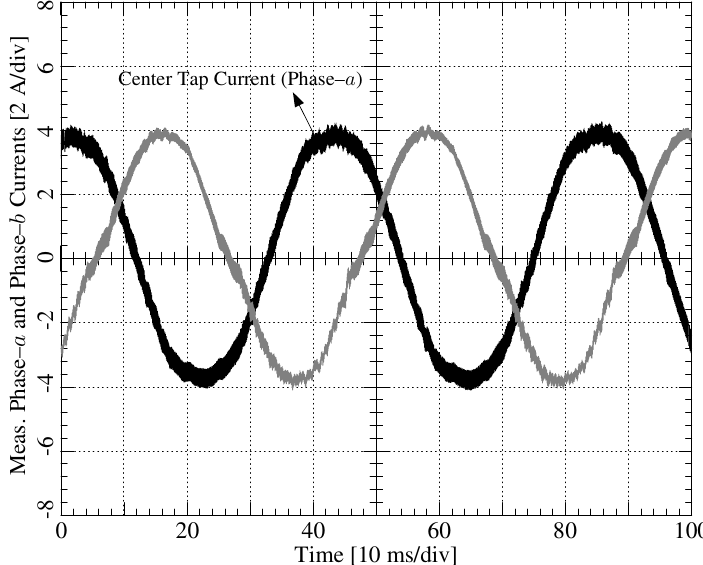
Figure 9. Experimental steady-state (360 r/min) phase- a and - b current waveforms under full load (2 N·m) without parameter detuning when K = 1